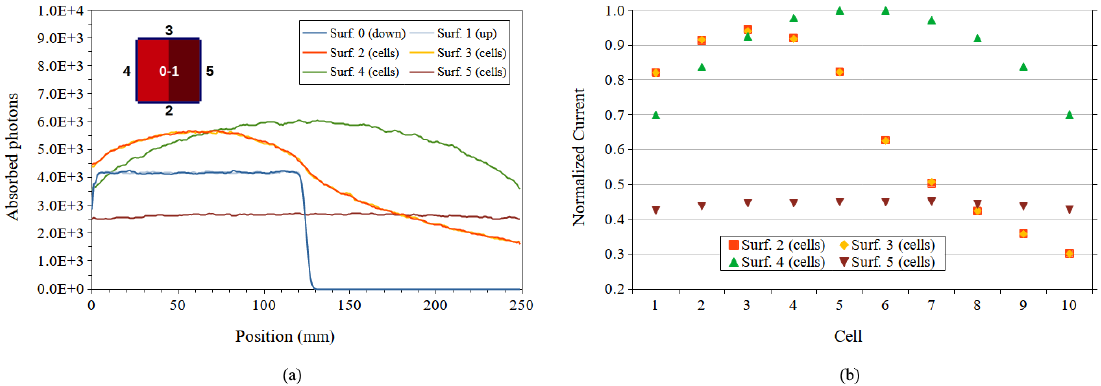
Figure 11. Shaded LSC panel with four 10-cells PV arrays: ( a ) Number of rays of light collected by the PV cells as a function of the position along the LSC side, which ranges from 0 mm to 250 mm. ( b ) Normalized current produced by each PV cell.